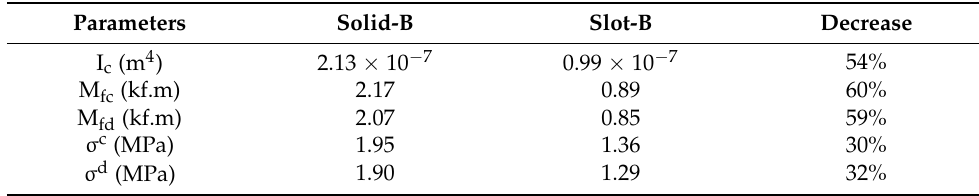
Figure 4. Single crack formed during the test: ( A ) sample after test; and ( B ) detail of the slot formed in the central axis of the previous failure. Table 4. Mechanical parameters.